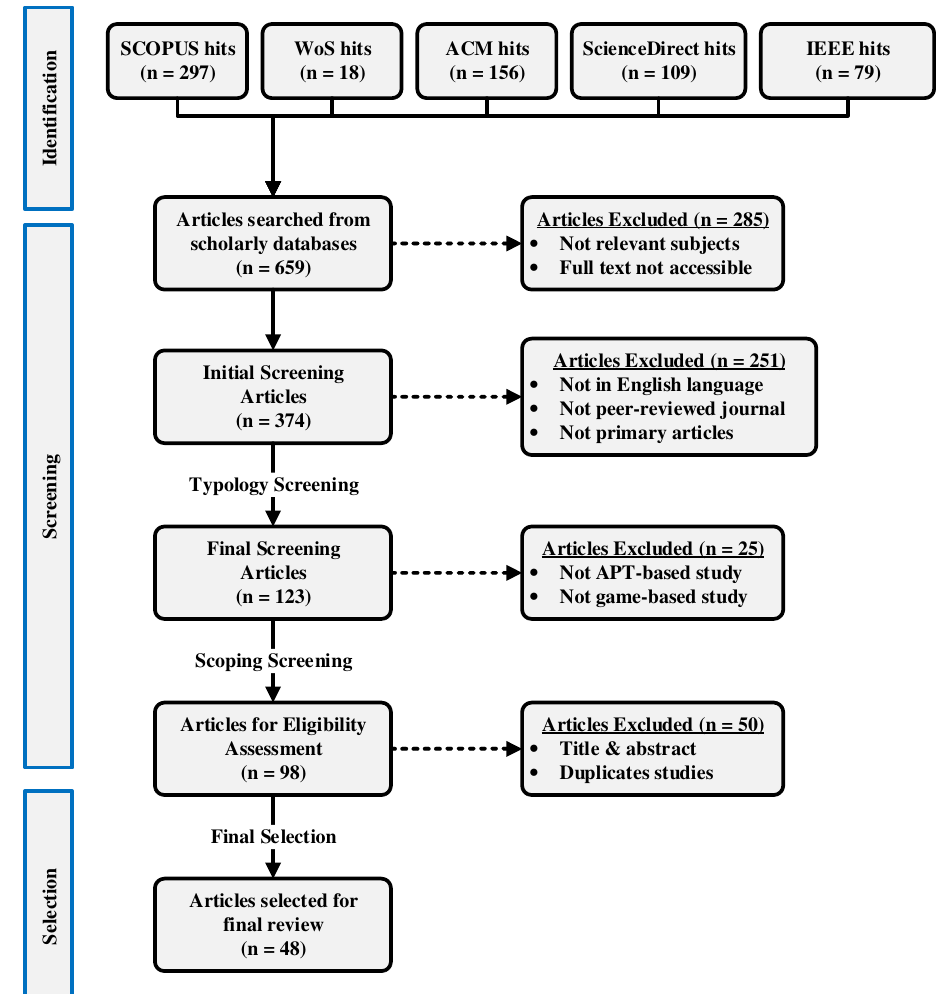
Figure 2. PRISMA flow diagram for the selection of the 48 main articles reviewed. The initial search was identified from five major scientific databases, screened through several filtering criteria, and the final selection was determined from an eligibility